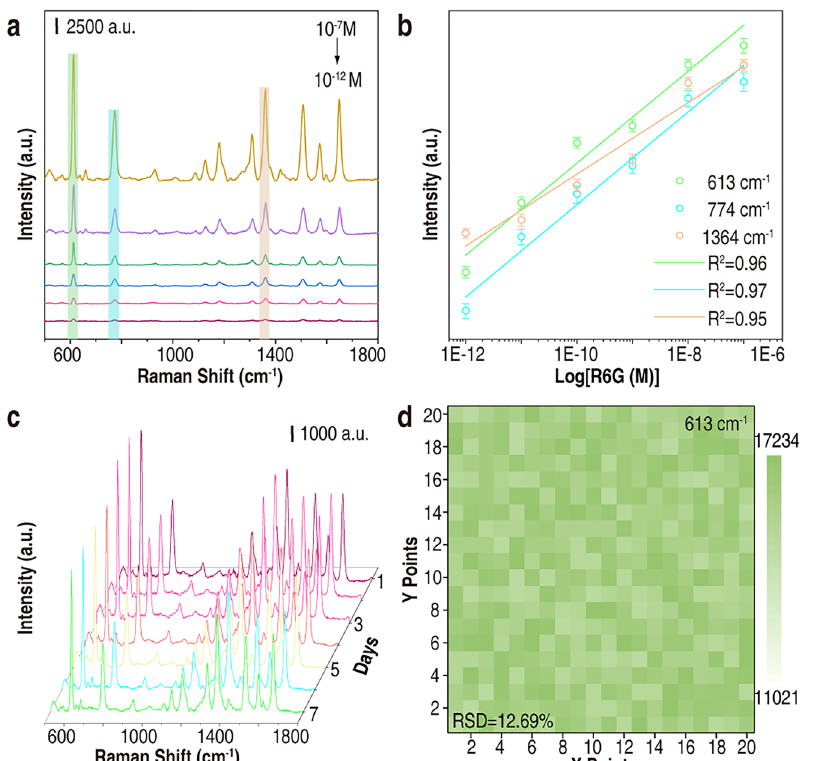
Figure 4: (a) Raman spectra of R6G (10 − 7 –